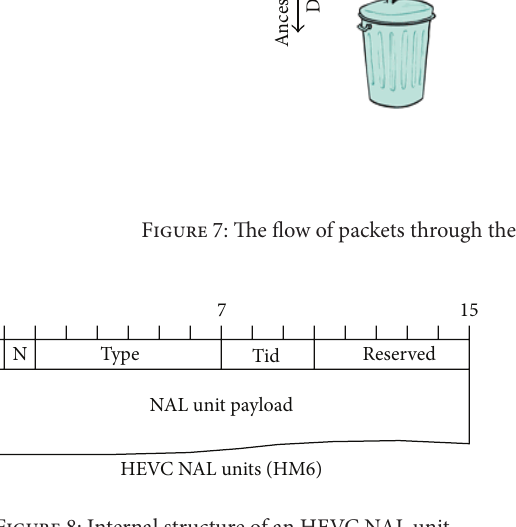
Figure 8: Internal structure of an HEVC NAL